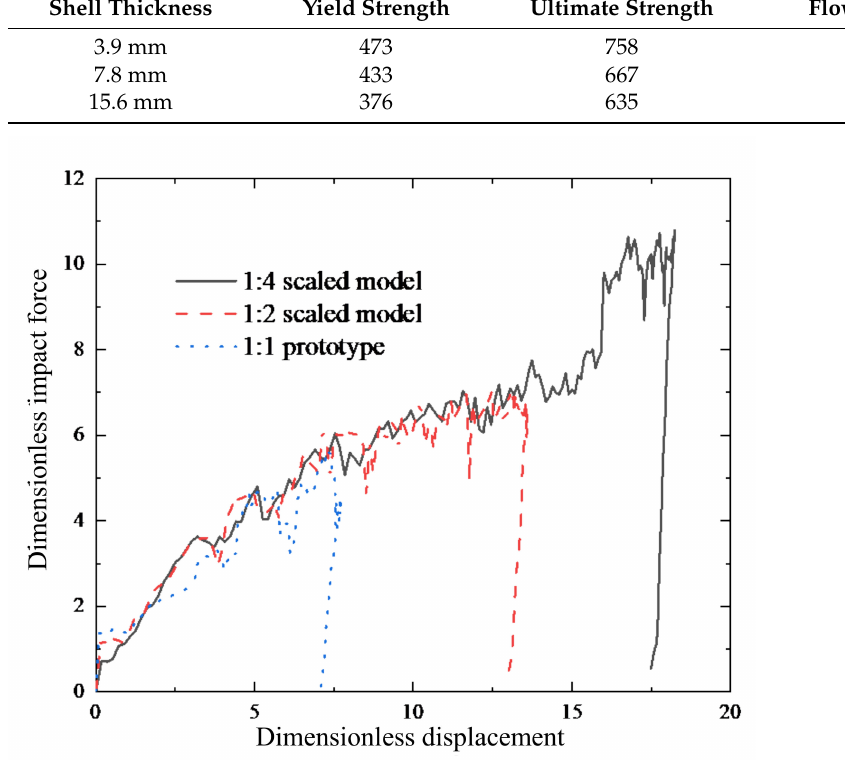
Figure 11. Comparison of the dimensionless force-displacement